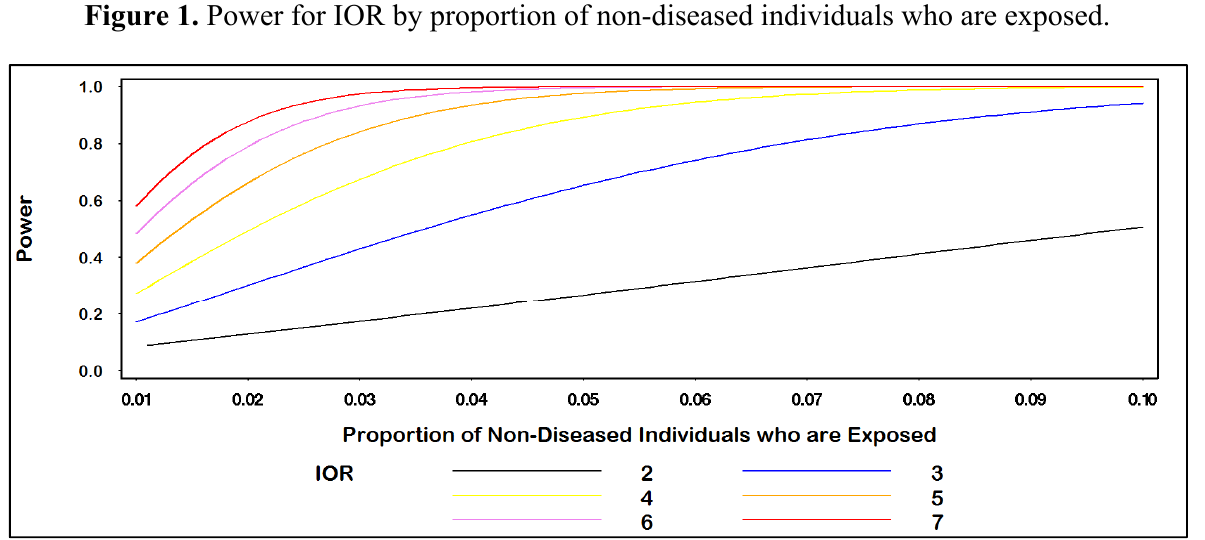
(Alpha = 0.05; No. non-diseased Pts. = 100; non-diseased: diseased ratio =